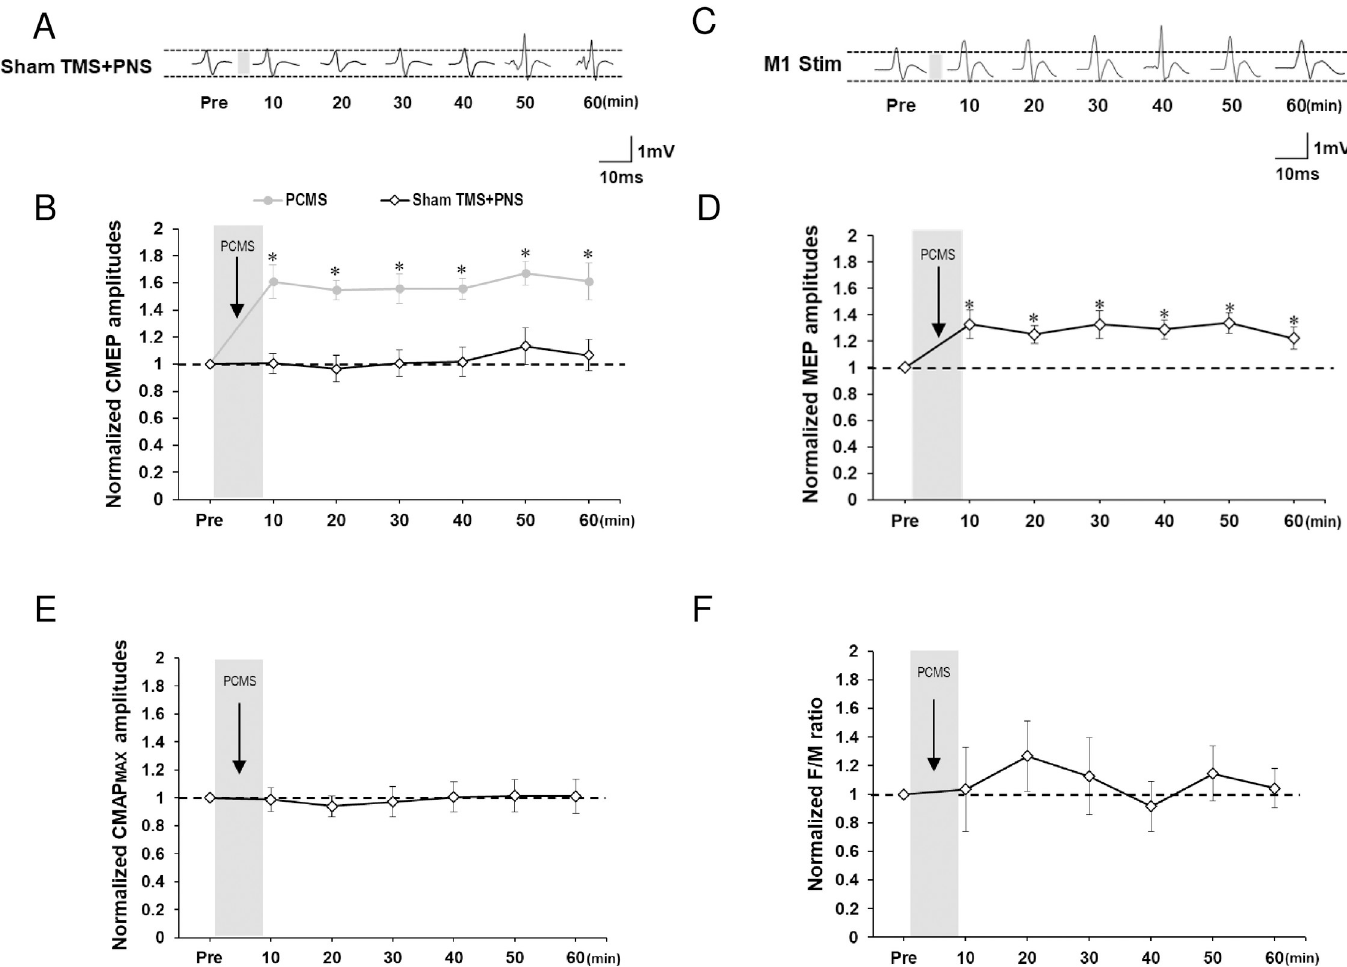
Fig 4. Time courses of PCMS effect in Experiment 3–5. (A) Representative CMEP waveforms before and after sham TMS-PNS pairs. (B) Repeated sham TMS-PNS pairs induced no significant changes in CMEP amplitudes. (C) Representative MEP waveforms before and after PCMS. (D) Cortical MEP amplitudes significantly increased after PCMS compared to the baseline. (E) CMAP amplitudes remained unchanged after PCMS. (F) PCMS did not affect the F/M ratio. � P < 0.05. All data are mean and standard-error